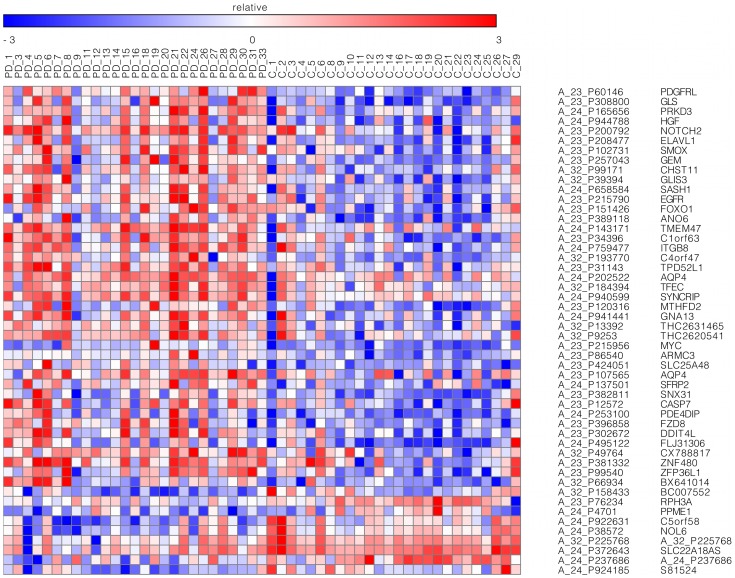
Top microarray probes.Probes with FDR-adjusted p-values smaller than 0.05 and with expression differences between PD and control prefrontal cortex BA9 samples greater than 1.5 fold changes. Twenty-one probes (42%) were in genes with FoxO1 transcription factor binding sites. The GENE-E software (http://www.broadinstitute.org/cancer/software/GENE-E/) was used to generate the heatmap.